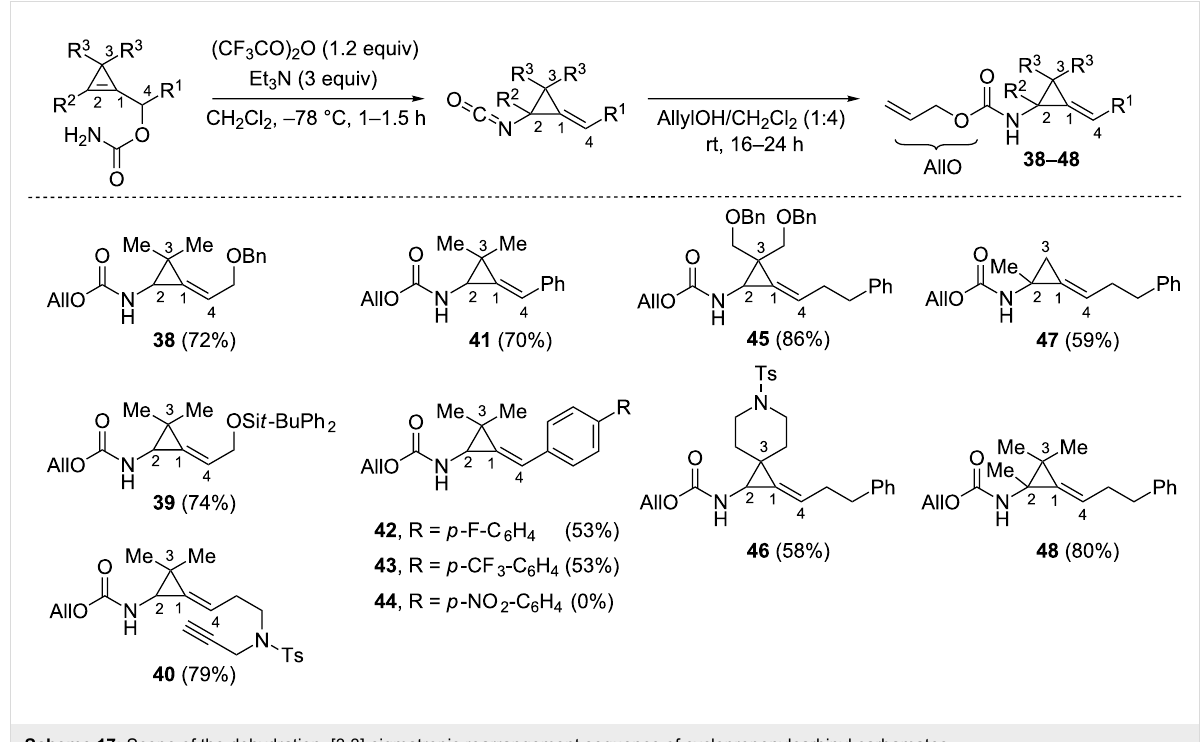
Scheme 17: Scope of the dehydration–[3,3]-sigmatropic rearrangement sequence of cyclopropenylcarbinyl carbamates.